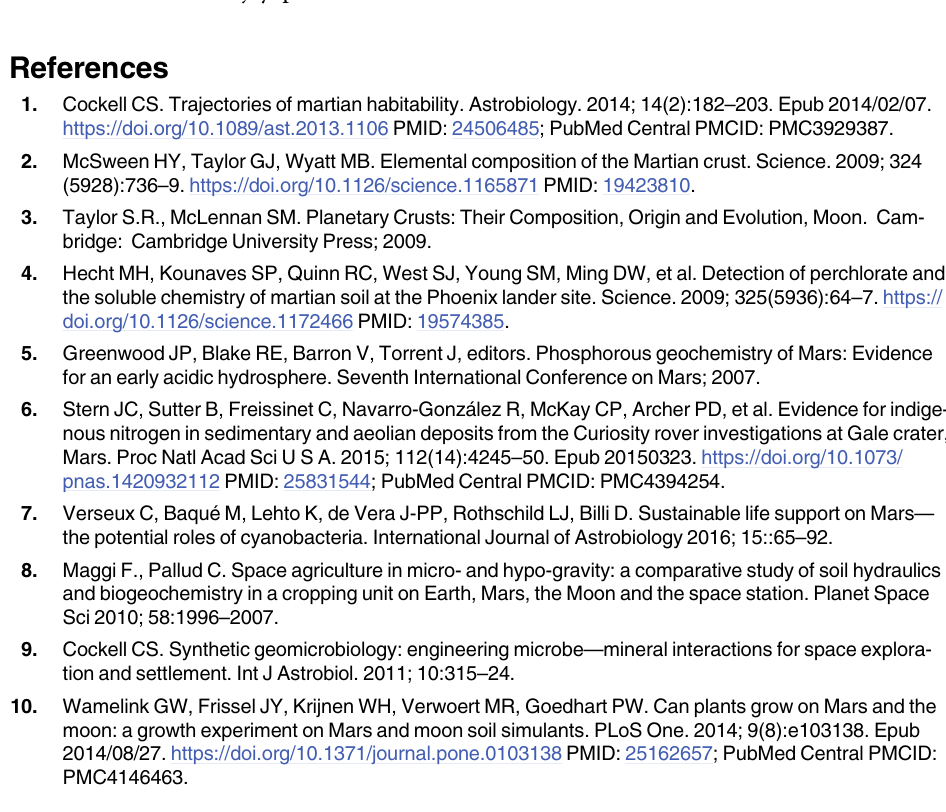
S5 Table. Raw data of growth of turnip (B) and radish (D) plants in alfalfa treated basaltic regolith simulant soil watered with filtered or unfiltered biodesalinated water, or fresh water (control) in Fig 7 in the